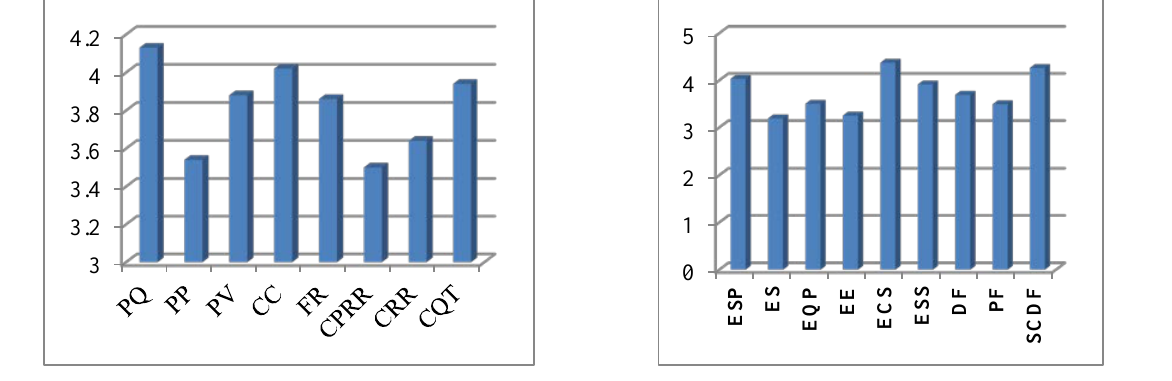
Fig. 6. Customer services perspective Fig. 7. Internal supply chain practices